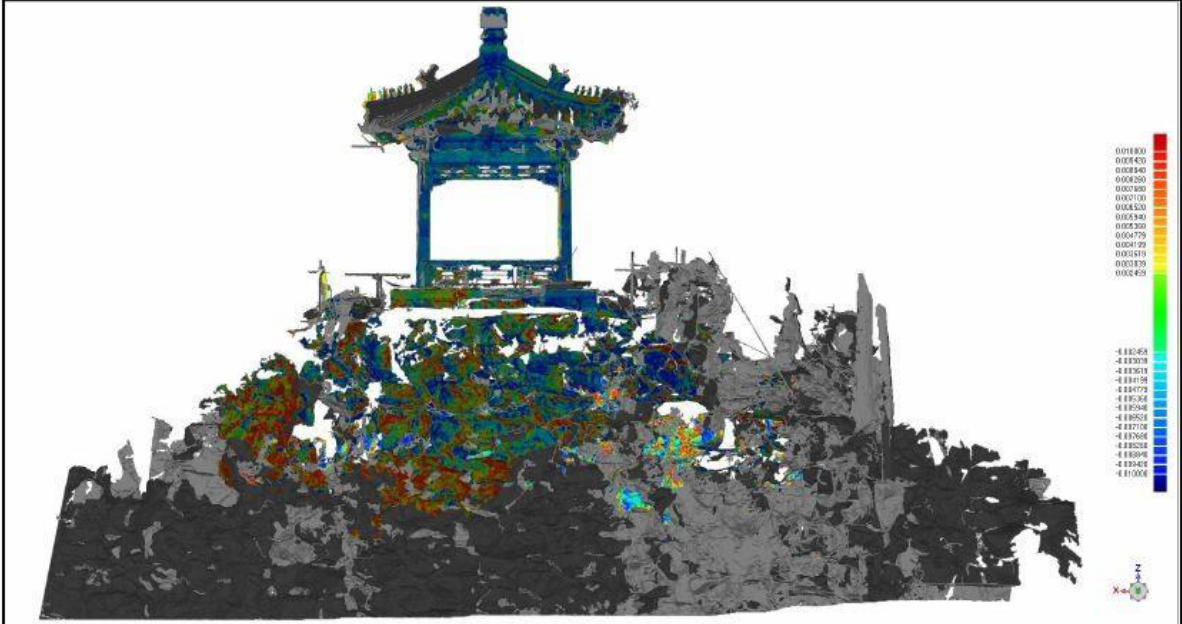
Figure 8. Model and point cloud overlay deviation distribution map